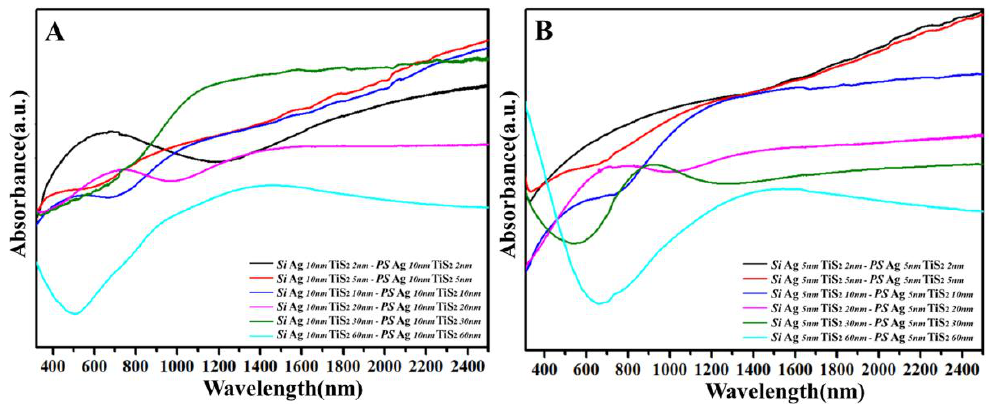
Figure 7. The di ff erent spectra of UV–Vis–NIR spectra for ( A ) Ag 10 nm / TiS 2 (t nm) nanostructures Figure 7. The different spectra of UV–Vis–NIR spectra for ( A ) Ag 10 nm/TiS 2 (t nm) nanostructures and ( B ) Ag 5 nm / TiS 2 (t nm) and ( B )Ag 5 nm/TiS 2 (t nm) nanostructures.